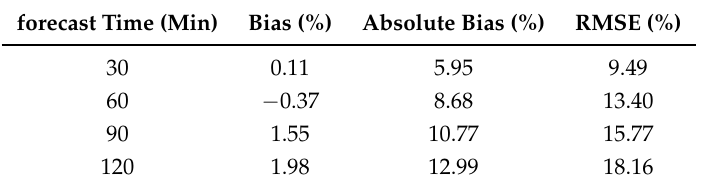
Table 3. Values of the bias, absolute bias and RMSE for the case of 30 September 2017. The basis for the calculation is the area of Europe.